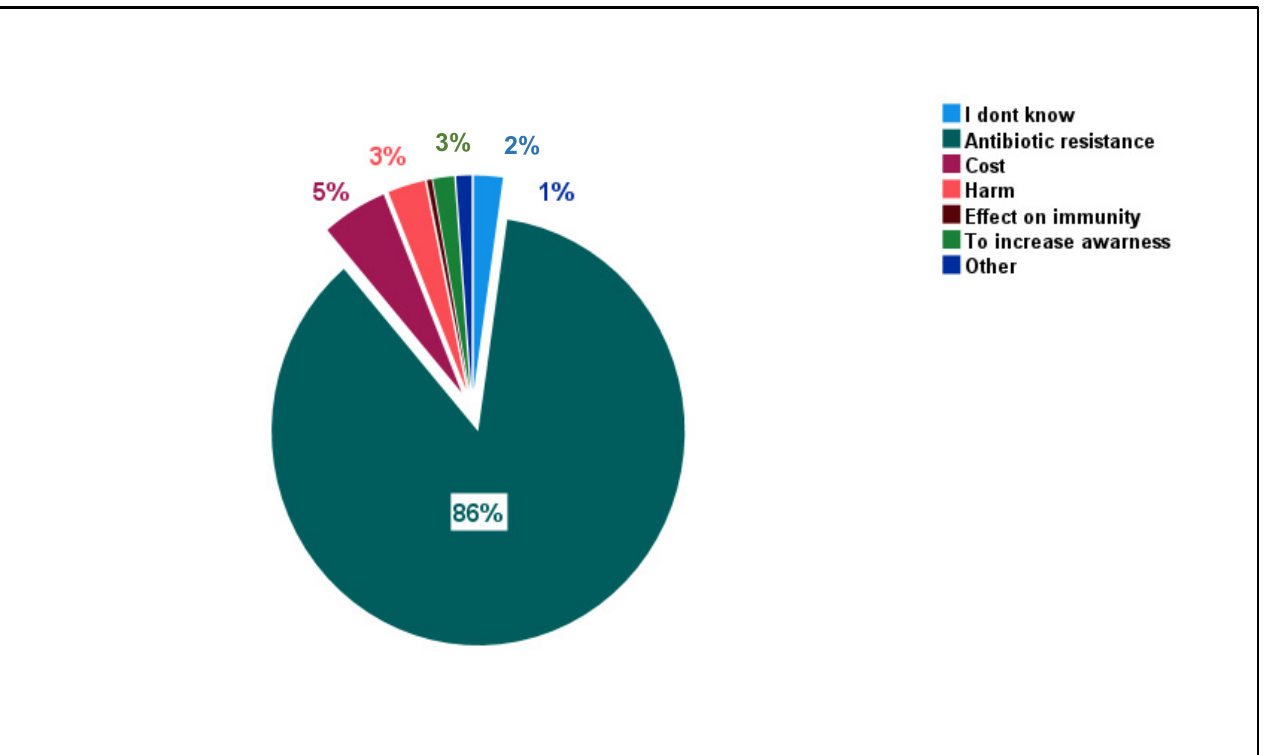
Figure 2. Different reasons given by survey participants to explain the Ministry of Health antibiotic restrictions.